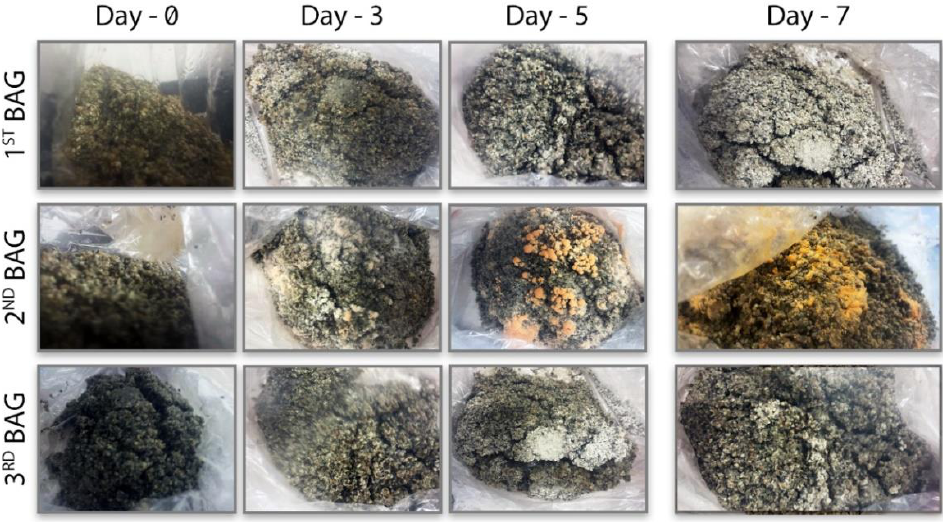
Figure 5. MCB contamination control experiments.